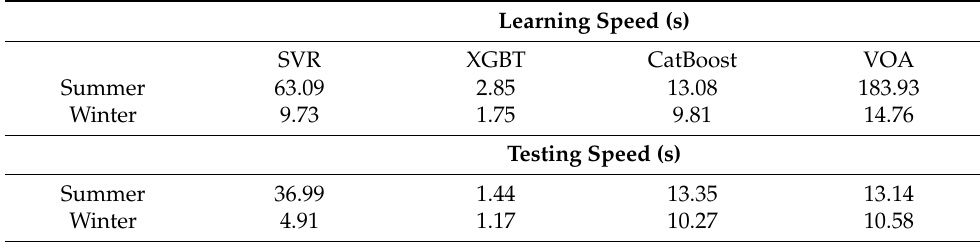
Table 7. Average learning speed in seconds (s) for all ML algorithms (1 h Day Observed